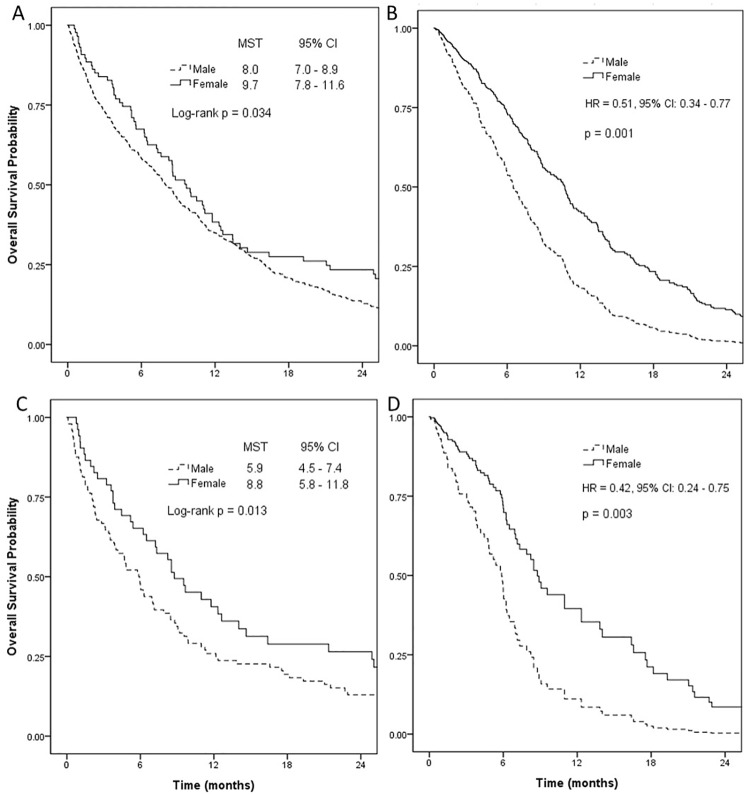
Overall survival of small-cell lung cancer patients by gender.(A) Kaplan-Meier plot and (B) fully adjusted Cox model in entire cohort; (C) Kaplan-Meier plot and (D) fully adjusted Cox model in propensity score matched cohort. MST, median survival time; CI, confidence interval.